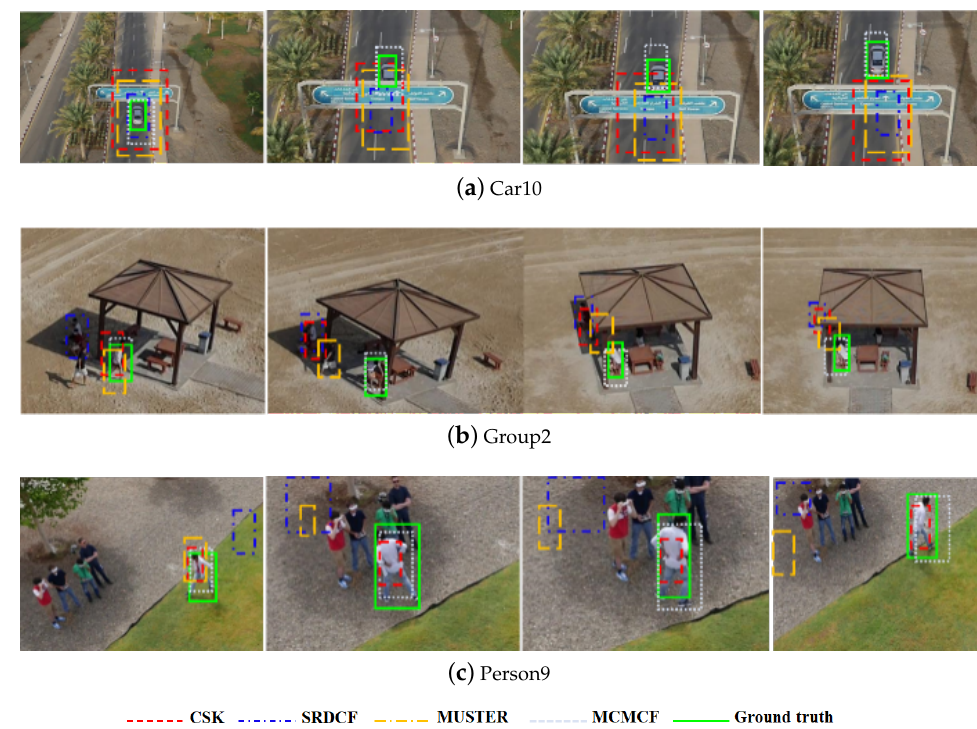
Figure 10. Results of different algorithms for some video sequences on the UAV123